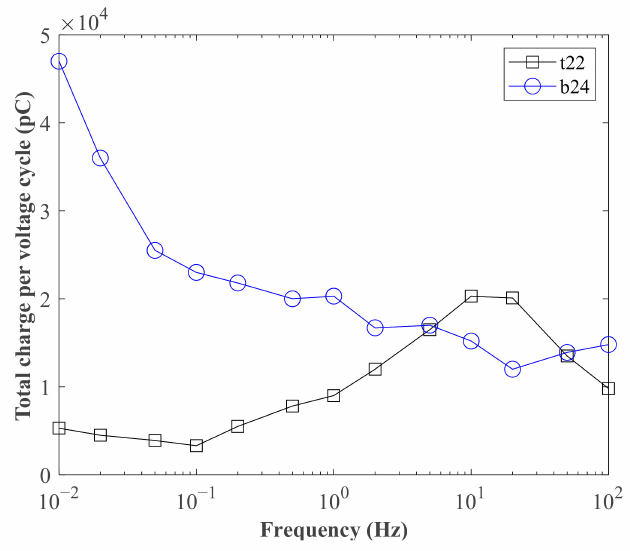
Figure 2. Total charge per voltage cycle of variable-frequency Phase Resolved PD Analysis (VF- PRPDA) measurements on two aged stator bars (epoxy-mica insulation) from a hydro-power genera- tor; t22, b24 refer to Micapact insulation, where t means the half-coil from the top of the slot and b denotes it from the bottom of the slot. Reproduced from